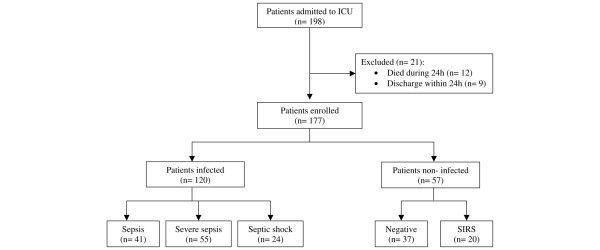
Patients included and excluded from the study. ICU, intensive care unit; SIRS, systemic inflammatory response syndrome.